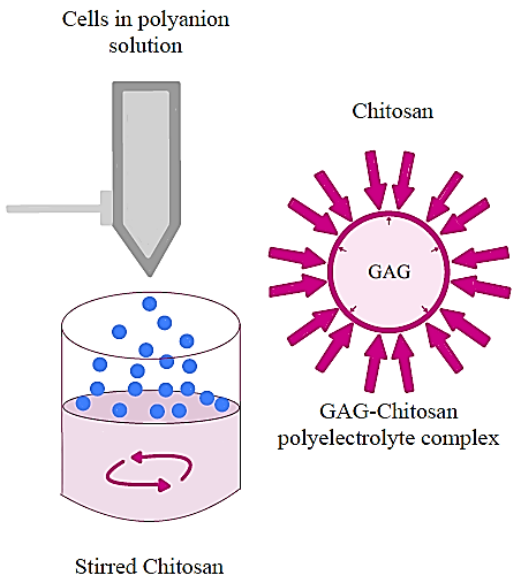
Figure 2. Schematic of the polyelectrolyte microcapsule